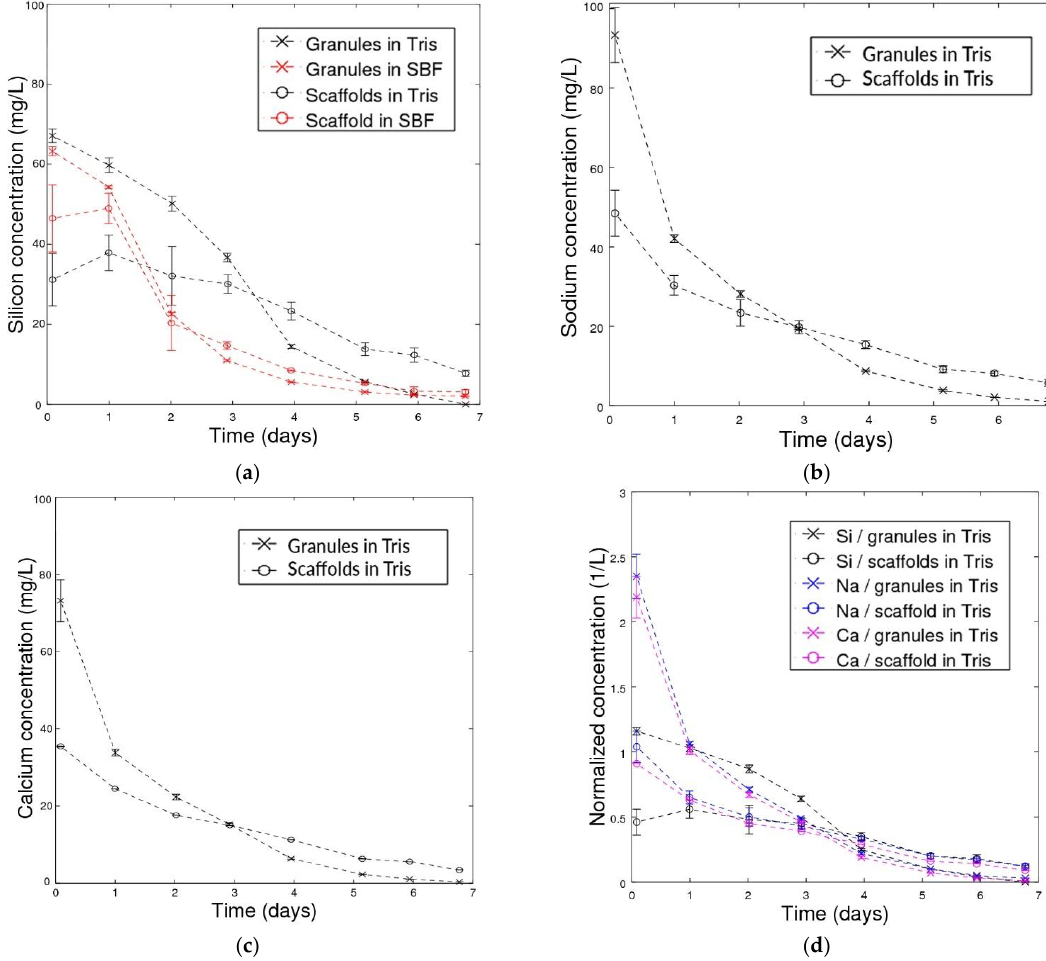
Figure 3. Ion concentrations dissolving from S53P4 granules and amorphous scaffolds under a continuous flow of Tris and SBF, in ( a ) silicon in Tris and SBF, ( b ) sodium in Tris and ( c ) calcium in Tris. In ( d ), concentrations released into the continuous flow of Tris as functions of time were normalized with respect to the amount of each element in the glass.